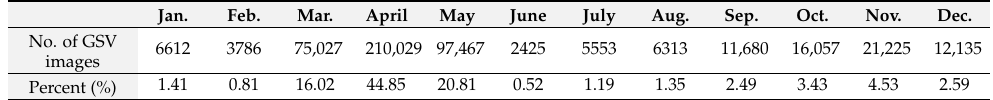
Table 1. Distribution of Google Steet View images by month.